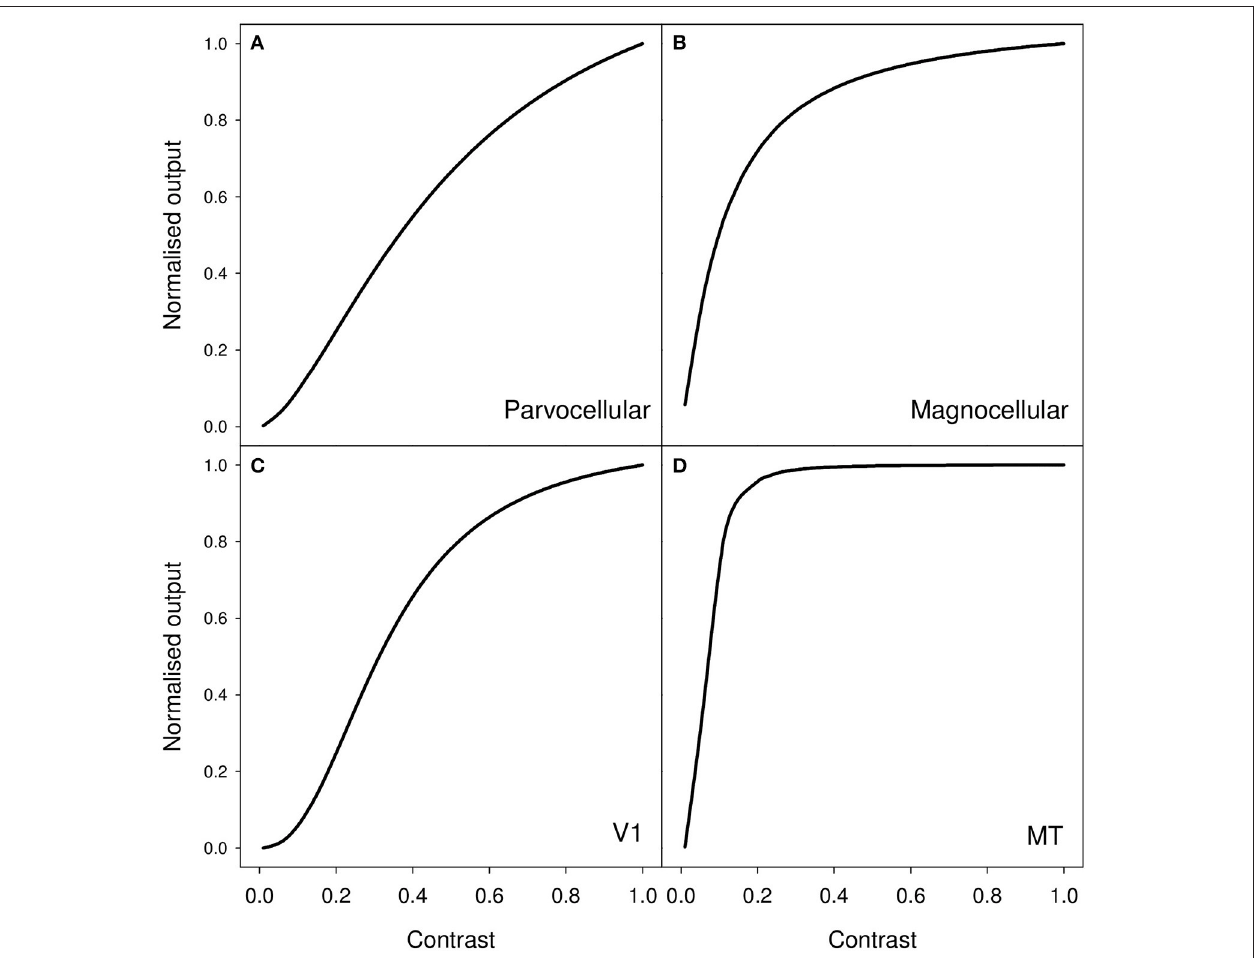
FIGURE 1 | Representative contrast response curves for the following sets of neurons in macaque (A) parvocellular LGN, (B) magnocellular LGN, (C) primary visual cortex (V1), and (D) middle temporal (MT/V5) area. The functions shown are generated from median values for fits of the Naka-Rushton function to cells in these various populations. These values are taken from Table 1 (p4) of Sclar et al.